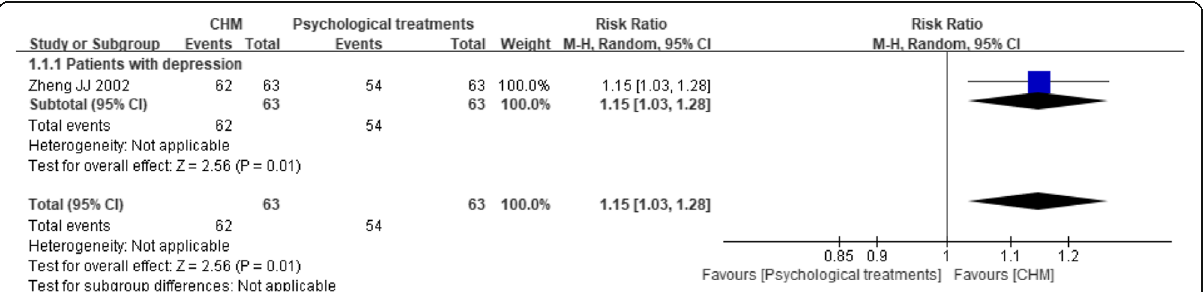
Fig. 8 Forest plot of the depression treatment response rate for CHM versus psychological